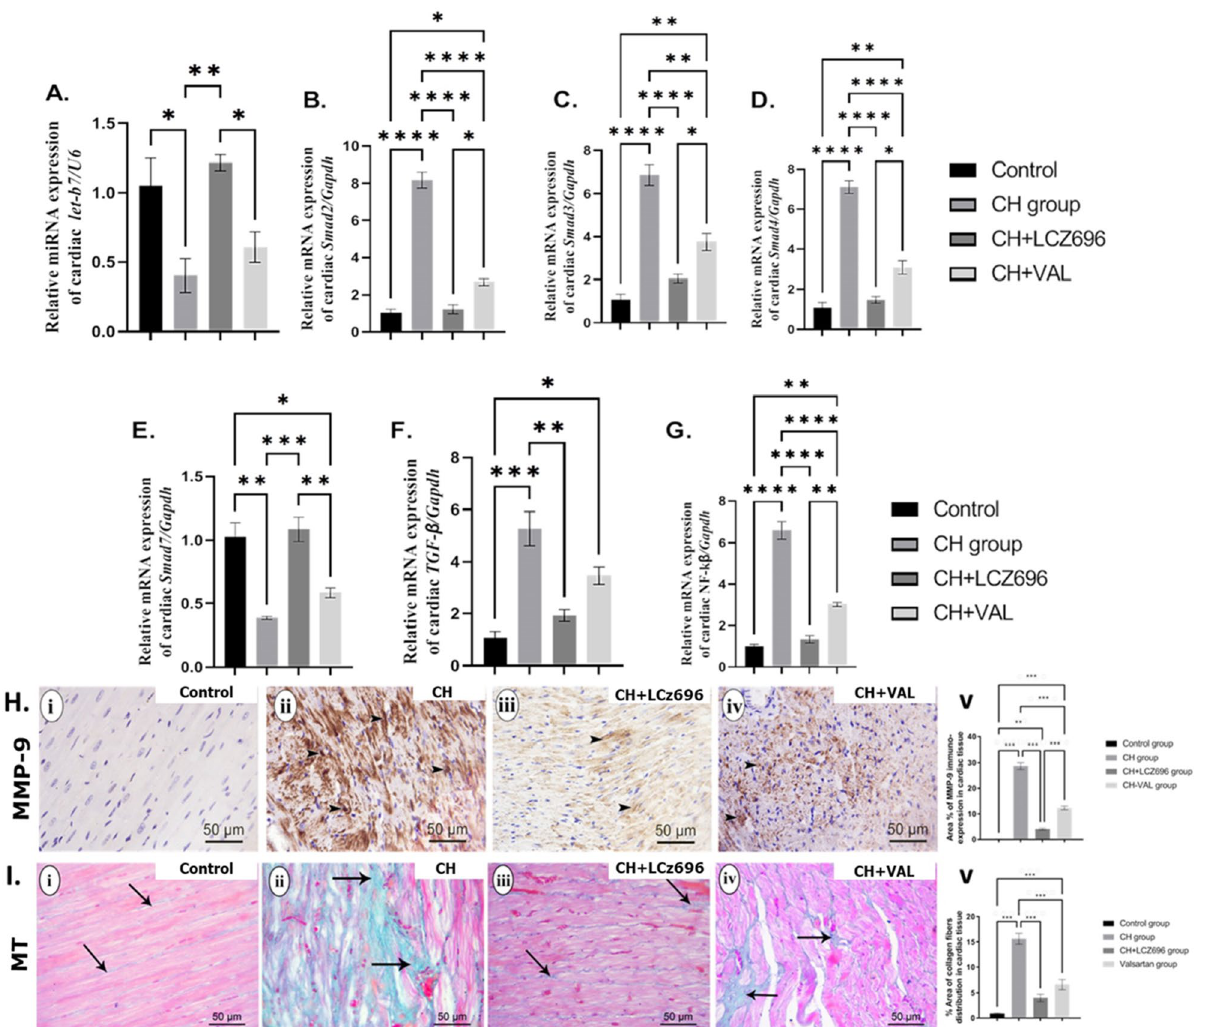
Figure 4. The effect of LCZ696 and VAL administration on the mRNA and protein expression of the cardiac fibrotic markers and their regulatory miRNA ( A – I ). ( A ) relative miRNA expression of cardiac Let-7b/U6 (%control), ( B ) relative mRNA expression of cardiac SMAD-2/Gapdh (%control), ( C ) relative mRNA expression of cardiac SMAD-3/Gapdh (%control), ( D ) relative mRNA expression of cardiac SMAD-4/Gapdh (%control), ( E ) relative mRNA expression of cardiac SMAD-7/Gapdh (%control), ( F ) relative mRNA expression of cardiac TGF-β/Gapdh (%control), ( G ) relative mRNA expression of cardiac NF-κβ/Gapdh (%control), ( H ) (i–v) representative photomicrographs showing the estimation of immunohistochemical staining of MMP-9 in rat cardiac tissues of the different experimental groups (i) Control group, (ii) CH group, (iii) CH + LCZ696 group, (iv) CH + VAL group, and (v) a bar chart demonstrates the changes in the area % of MMP-9 immune-positive cells of the different experimental groups, and ( I ) (i–v) representative photomicrographs showing the estimation of the collagen deposition by Masson Trichome staining in rat cardiac tissues of the different experimental groups (i) Control group, (ii) CH group, (iii) CH + LCZ696 group, (iv) CH + VAL group, and (v) a bar chart demonstrates the changes in the area % of the collagen deposition of the different experimental groups. Values are mean of 6 rats per group ± S.E.M * p < 0.05; ** p < 0.01; *** p < 0.001. Group means were compared by one-way analysis of variance (ANOVA) followed by Tukey post hoc tests for multiple marker MMP-9, collagen fiber accumulation 17 , and upregulation of various fibrotic marker genes and the regu-